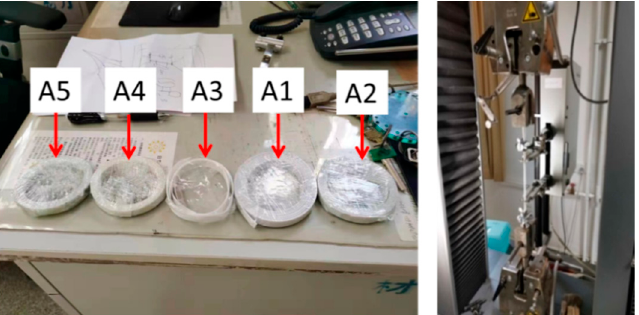
Figure 8. The five PP bands and the tensile test setup.